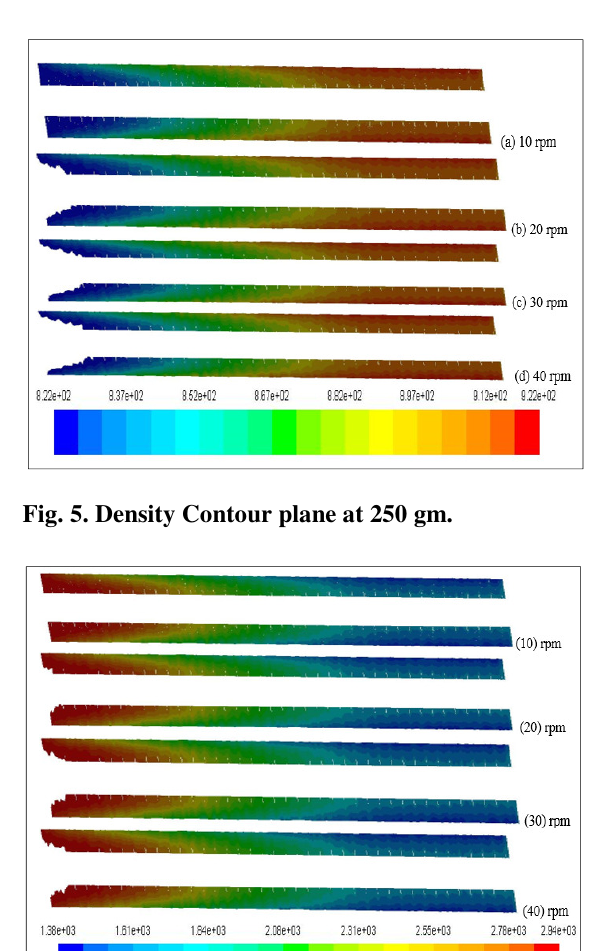
Fig. 7. Thermal conductivity Contour plane at 250 gm.